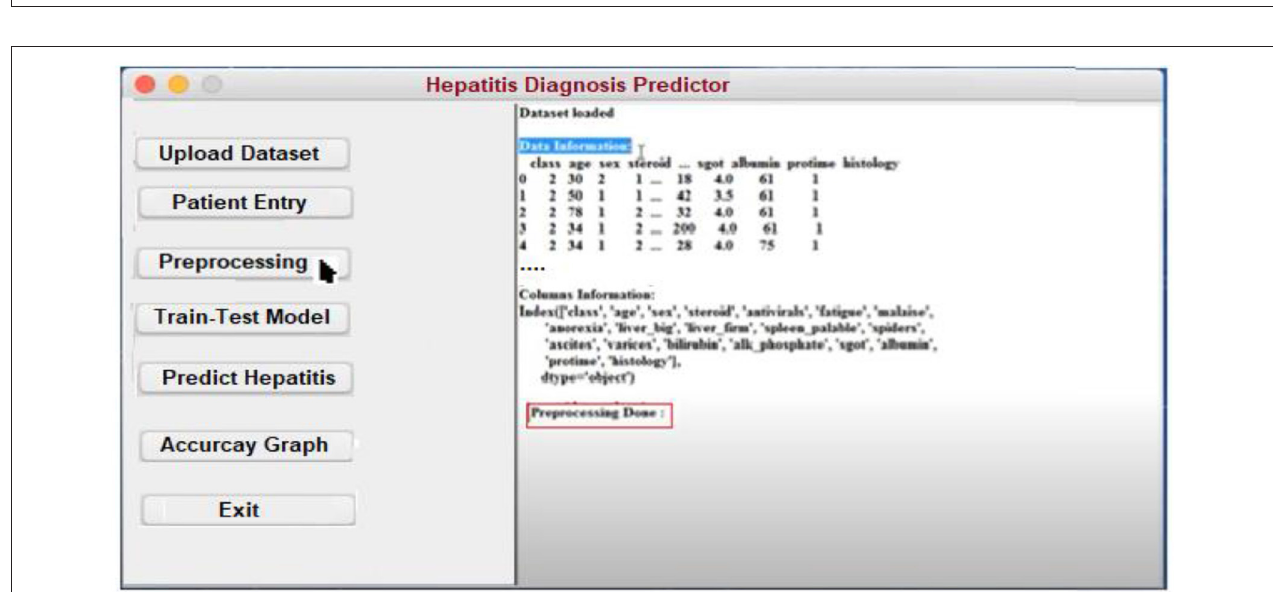
FIGURE 10 | Preprocessing form for Hepatitis